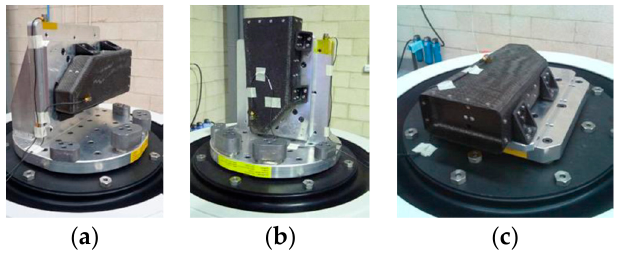
Figure 24. Breadboard mounted on the shaker table for testing in different directions ( a ) X direction ( b ) Y direction ( c ) Z direction. Table 21. Summary of breadboard mechanical test results. Freq. : Frequency. Natural Frequencies